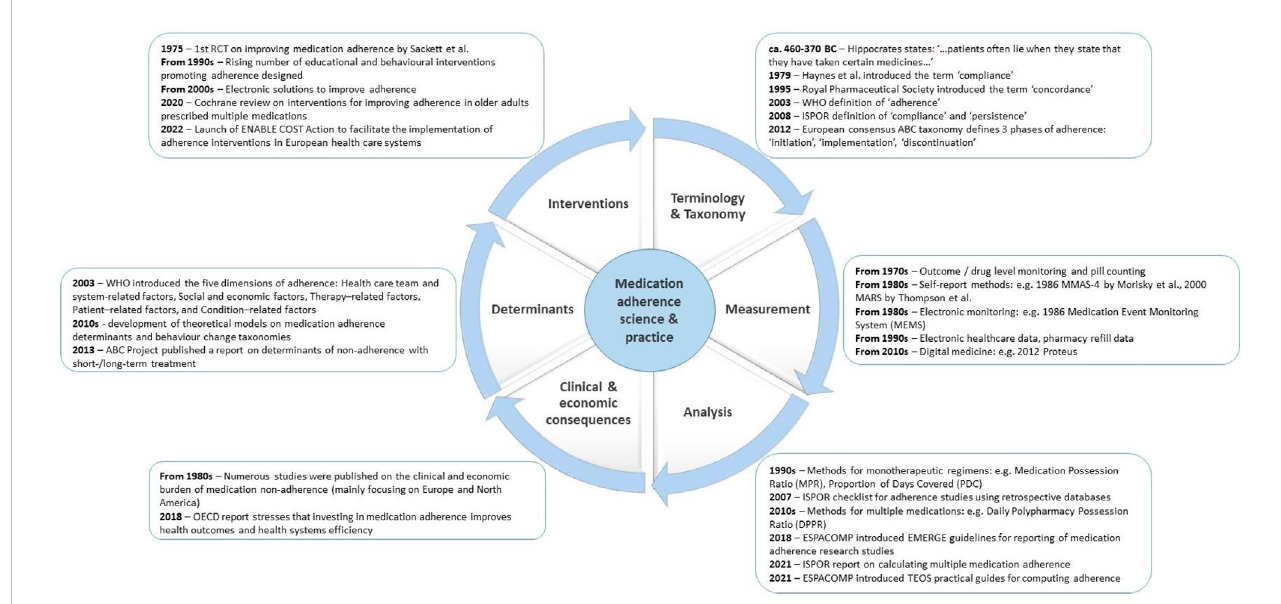
Milestones of medication adherence-related science and practice. Notes: ENABLE — European Network to Advance Best practices and technoLogy on medication adherencE ” (ENABLE) COST Action, ESPACOMP — International Society for Medication Adherence, ISPOR - International Society